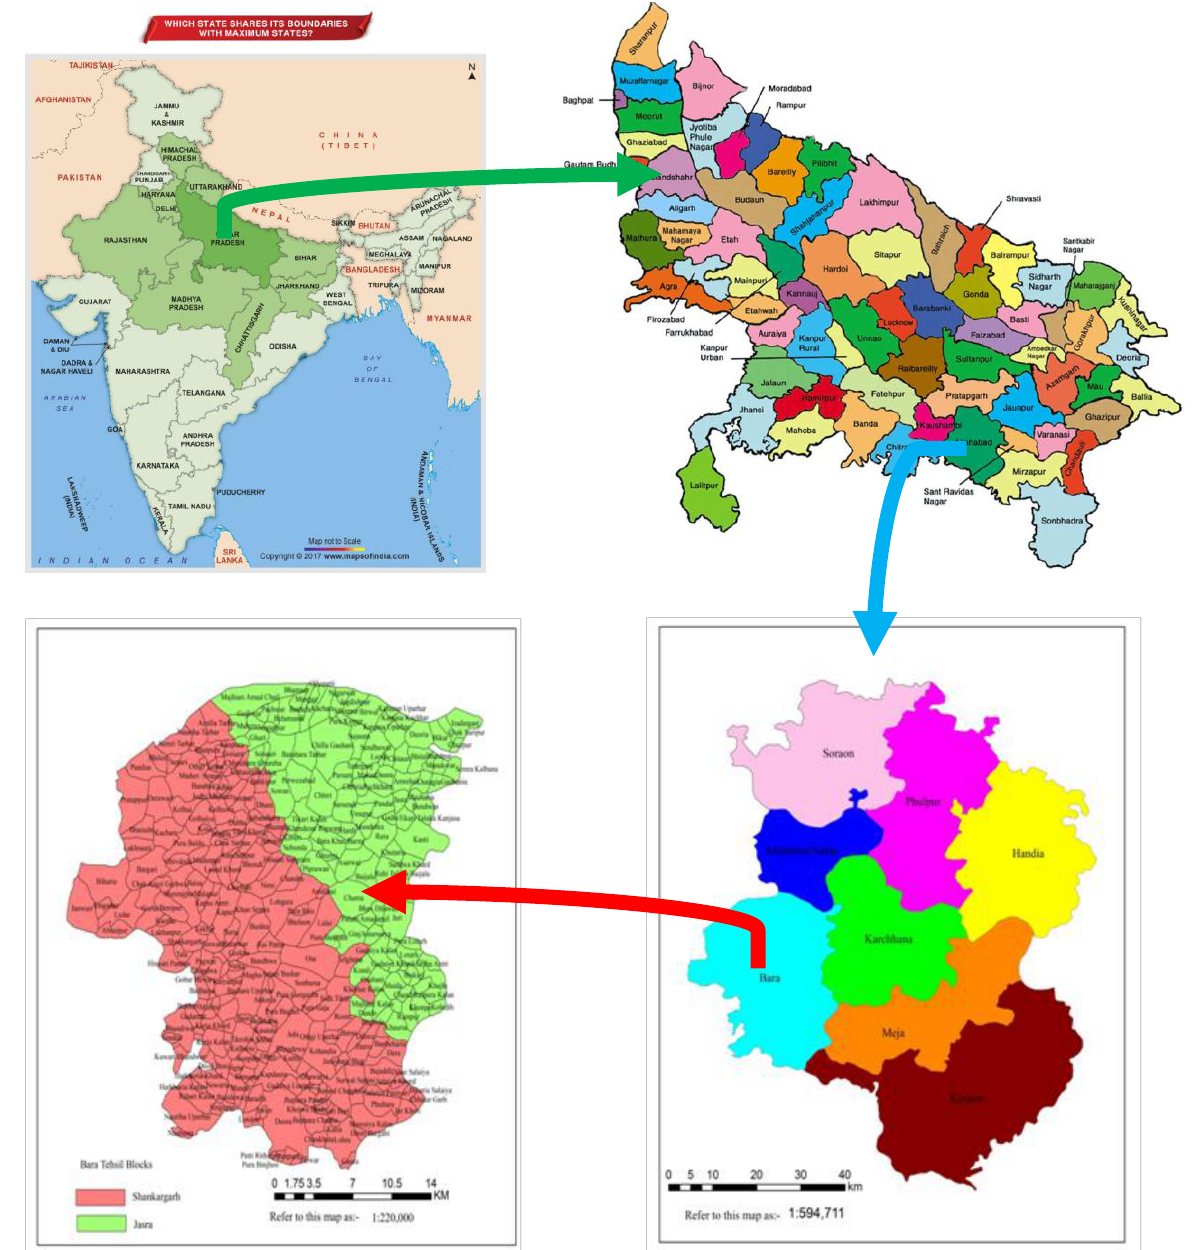
Figure 1. Bara tehsil location